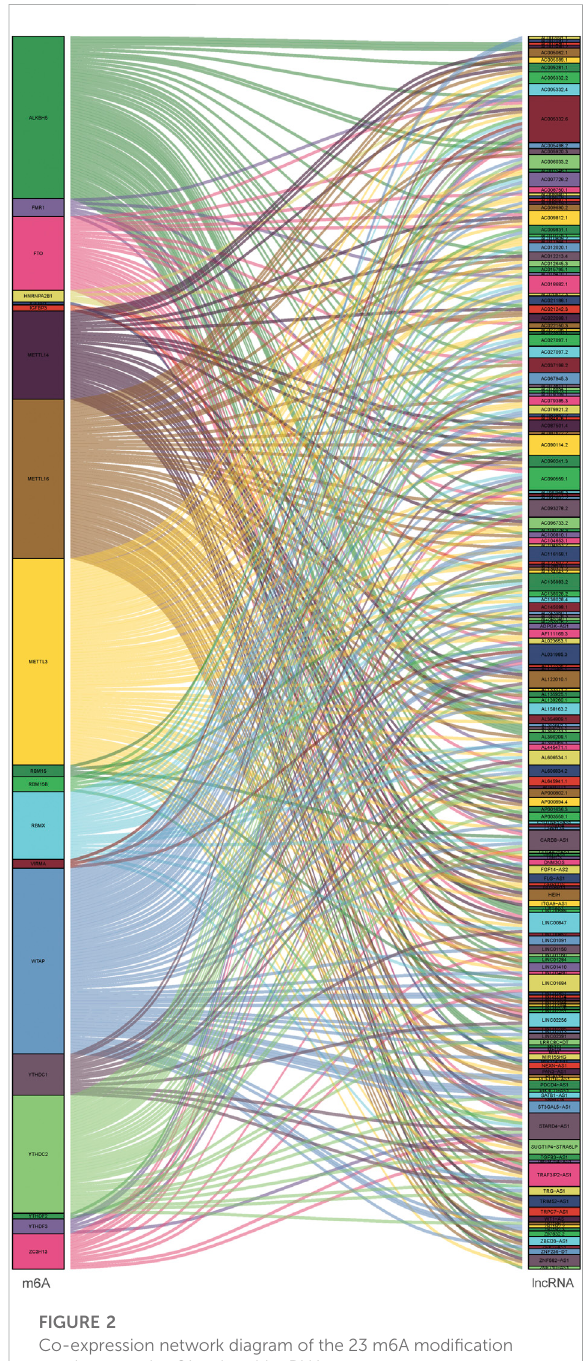
FIGURE 2 Co-expression network diagram of the 23 m6A modi fi cation regulators and m6A-related